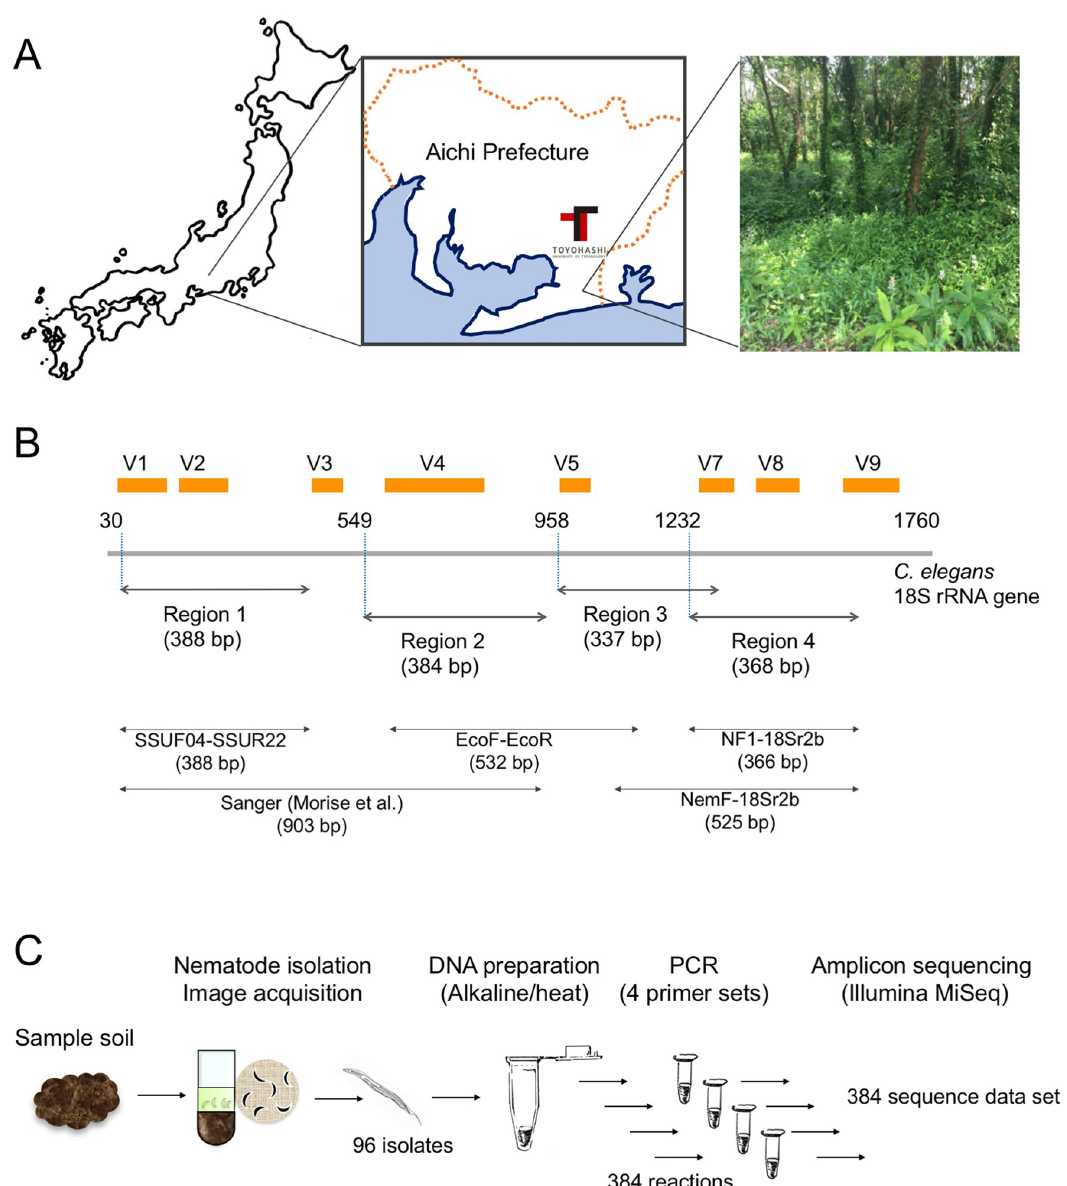
Fig 1. Soil sampling site, PCR target regions of 18S rRNA gene, and experimental scheme of this study. Sample soils for nematode isolation were obtained from the copse (picture) at the campus of Toyohashi University of Technology, Aichi Prefecture, Japan (A). Four PCR target regions (regions 1–4, with amplicon sizes shown) used in this study are indicated by double-headed arrows (B). The numbers indicating the nucleotide positions of the 5’-end of forward primers are shown on the entire SSU gene prepared from the nucleotide sequence of the C . elegans ribosomal RNA gene cluster (X03680). Orange boxes correspond to the hypervariable regions of the eukaryotic SSU genes reported by Hugerth et al. [38] and Hadziavdic et al. [45]. The regions that were amplified by the four indicated published primer sets (SSUF04-SSUR22 [29], EcoF-EcoR [24], NF1-18Sr2b [20], and NemF-18Sr2b [21]), as well as the amplified region from our previous study [19], are indicated by double-headed arrows with amplicon sizes shown. The experimental scheme of the amplicon sequencing that was prepared from the four SSU regions using 96 nematode isolates is shown (C). Fig 1 was produced by the authors specifically for this manuscript.